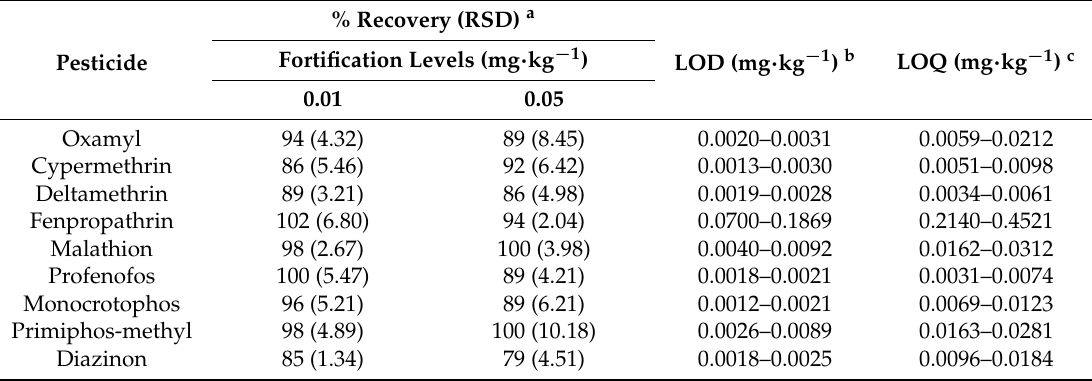
Table 1. Determinations of pesticides in fruit and vegetable